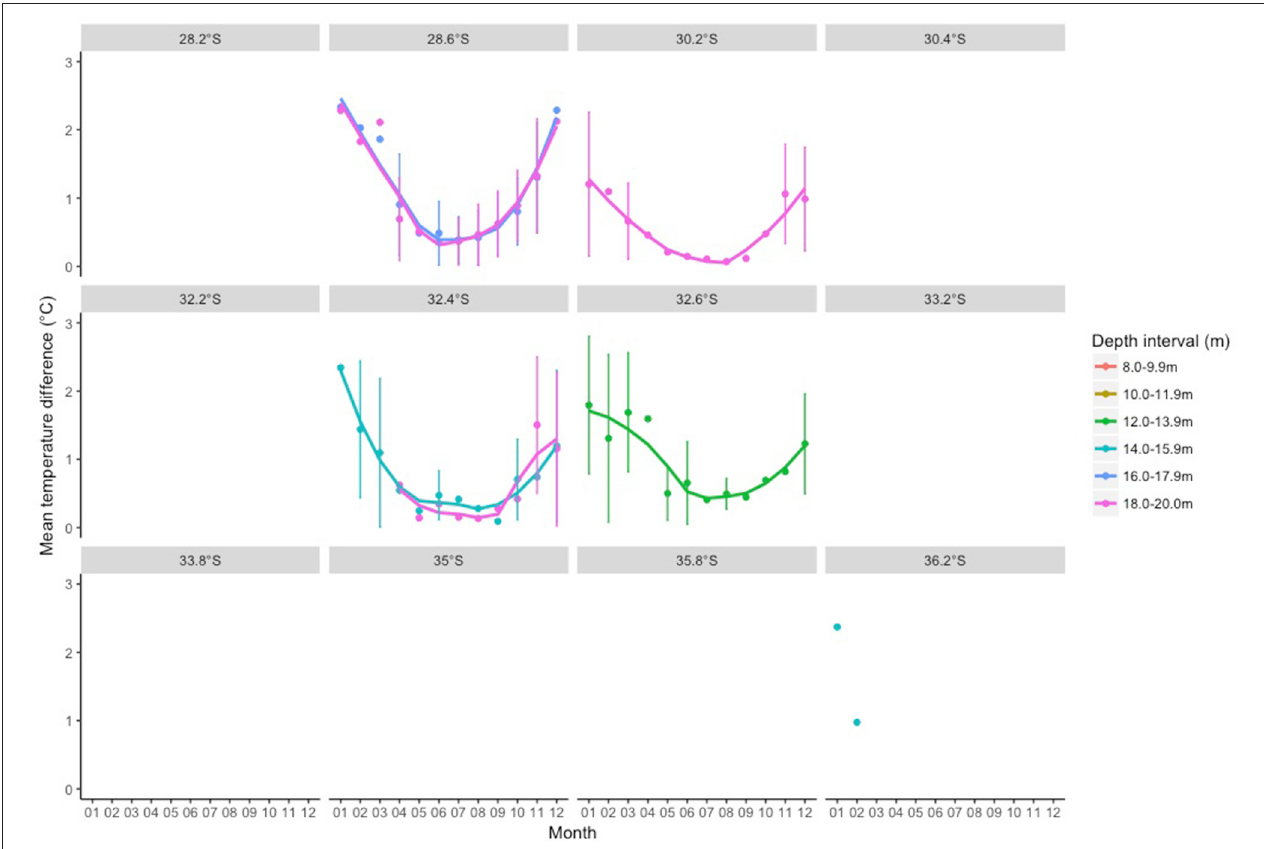
FIGURE 8 | Mean temperature differences between in situ and satellite that was processed at each logger location (i.e. no area averaging).